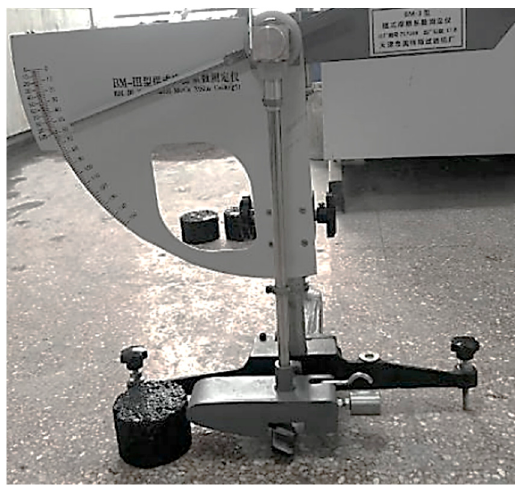
Figure 6. The photograph of pendulum instrument.